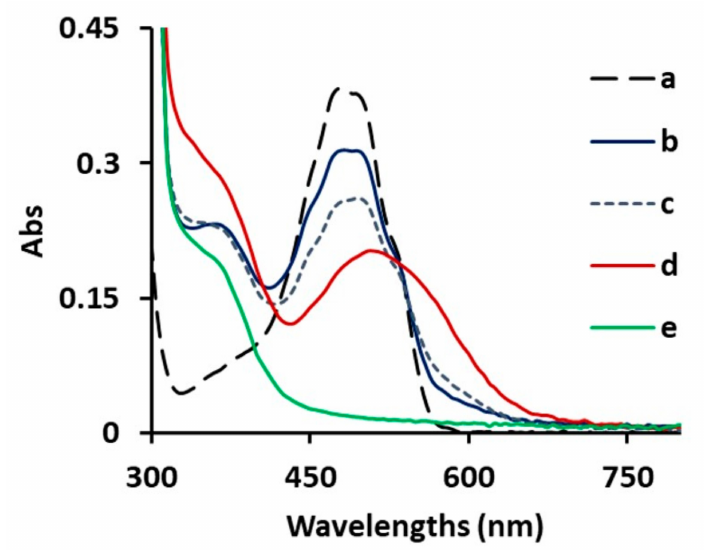
Figure 4. UV-vis spectra of Doxorubicin 2.9 × 10 − 5 M in H 2 O: ( a ) solution not titrated. ( b ) One mL of solution titrated with 3 mg of 3a . ( c ) One mL of solution titrated with 3 mg of 3a and aged for 5 days. ( d ) One mL of solution titrated with 3 mg of 3a and aged for 25 days. ( e ) UV spectra of 3a in water, 3 mg /